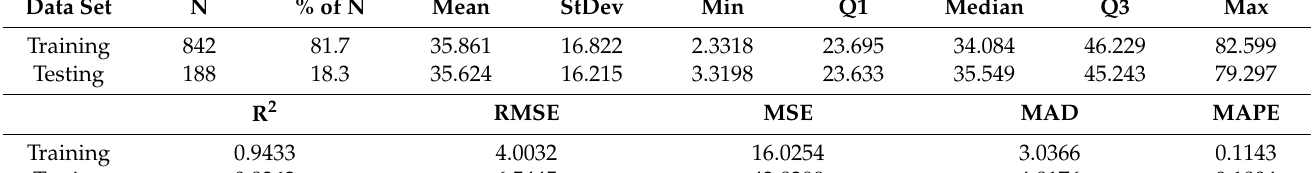
Table 2. Statistical Model Summary of Training and Testing Dataset Using DT Modeling.